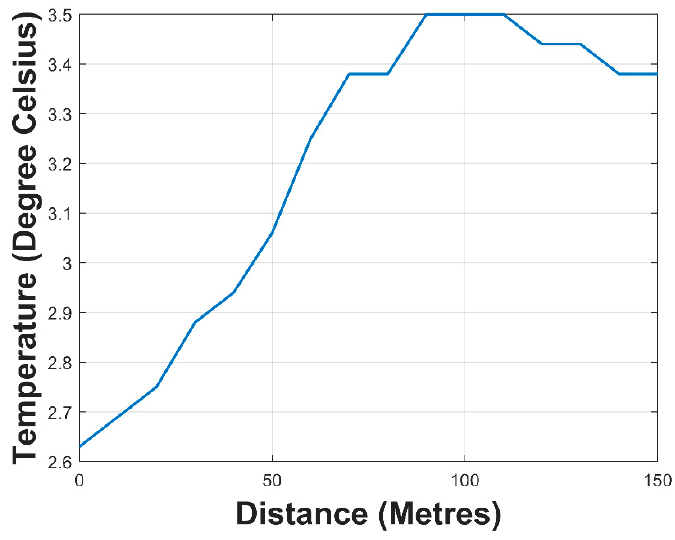
Figure 19. Temperature sensor data.